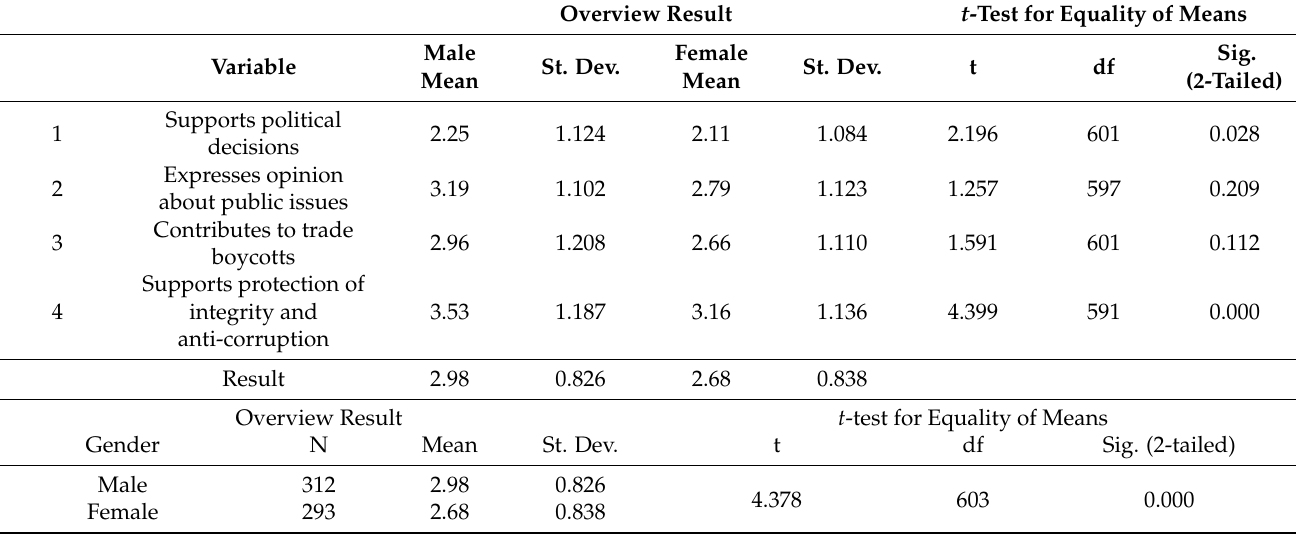
Table 7. Gender comparison: Political